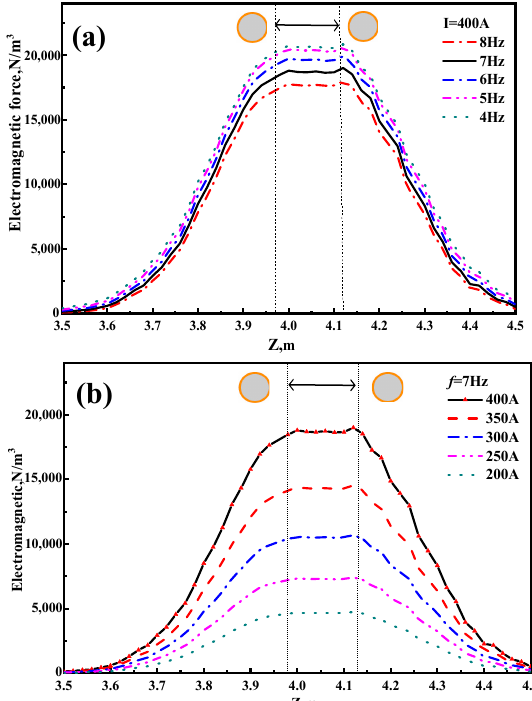
Figure 8. Distribution of the electromagnetic force in the casting direction under the two pairs of rollers at ( a ) different frequencies and under ( b ) different currents. rollers at ( a ) different frequencies and under ( b ) different